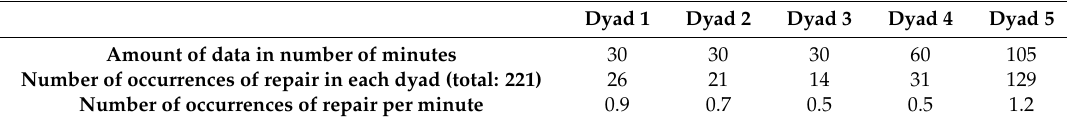
Table 2. Distribution of number of occurrences of repair in the five